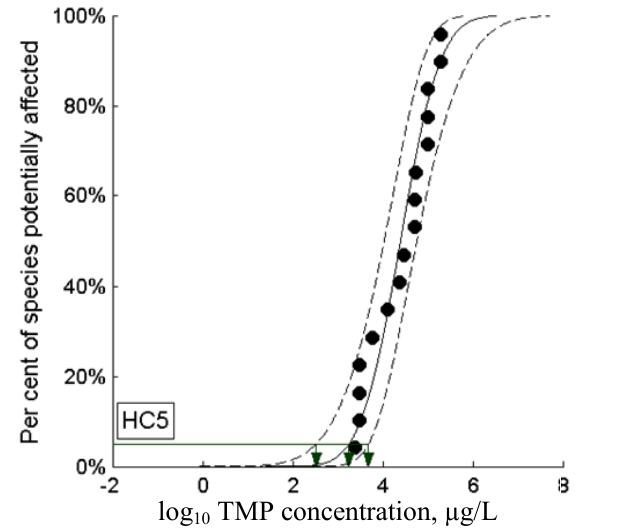
Figure 4. Webfram: chronic aquatic NOEC values and HC5. Chronic aquatic NOEC values (black dots) for TMP, percent-ranked and plotted by Webfram on a log-probabilistic scale; the 95% confidence interval is given as dashed lines. The Webfram-calculated probabilistic HC5 is 1,778 µg/L (middle green arrow) and the 95% confidence interval for the HC5 lies between 334 and 4,832 µg/L (left and right green